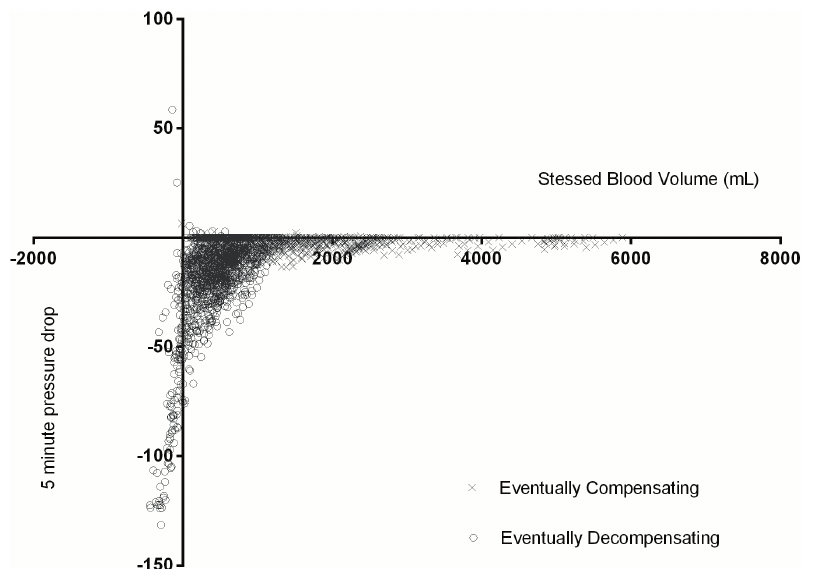
Figure 6. The relationship between stressed blood volume and average pressure drop over 5 minute intervals. Crosses represent eventually compensating, and circles eventually decompensating individuals. Significant pressure drops do not occur until the stressed volume approaches 0.